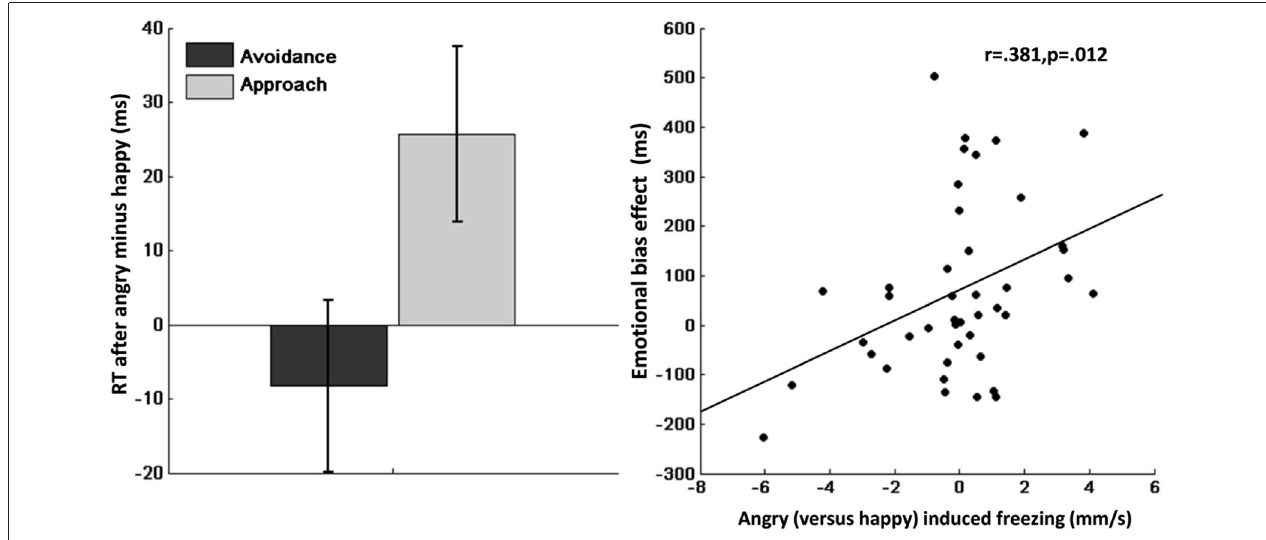
emotional bias effect. Angry (vs. happy) induced freezing corresponds to sway (mm/s) during happy minus angry (x-axis). Emotional bias effect corresponds to angry (vs. happy) induced slowing of approach (vs. avoidance)